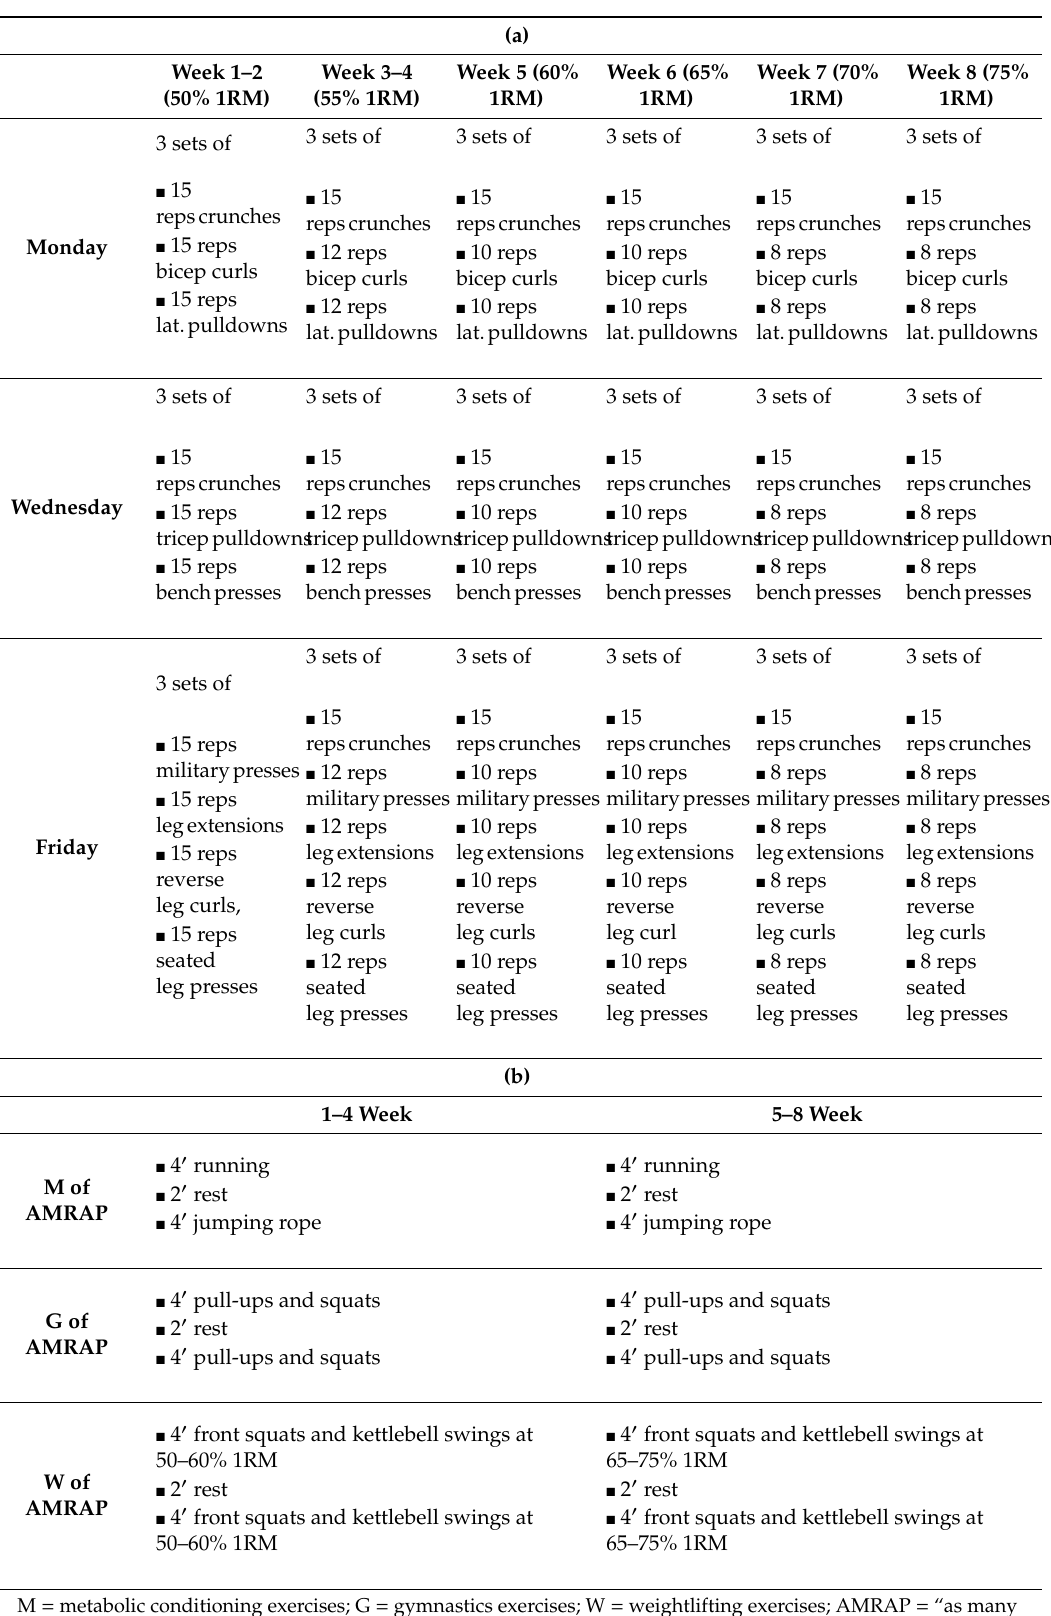
Table 1. Workload components of the training regimes (RT and CrossFit ® ) throughout the 8-week study. (a) Resistance Training; (b) CrossFit ®